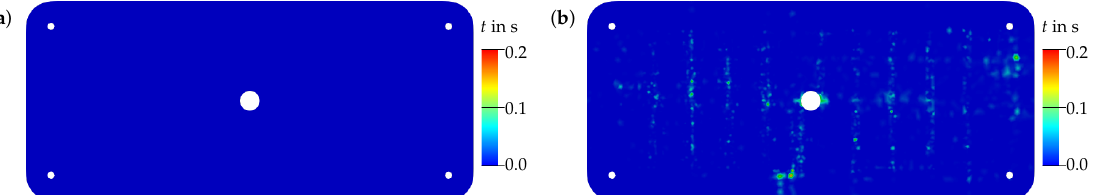
Figure 9. Error analysis of the prediction: ( a ) Sample 76: numerical result (all zero values for t m ; ( b ) Sample 76: predicted result by Random